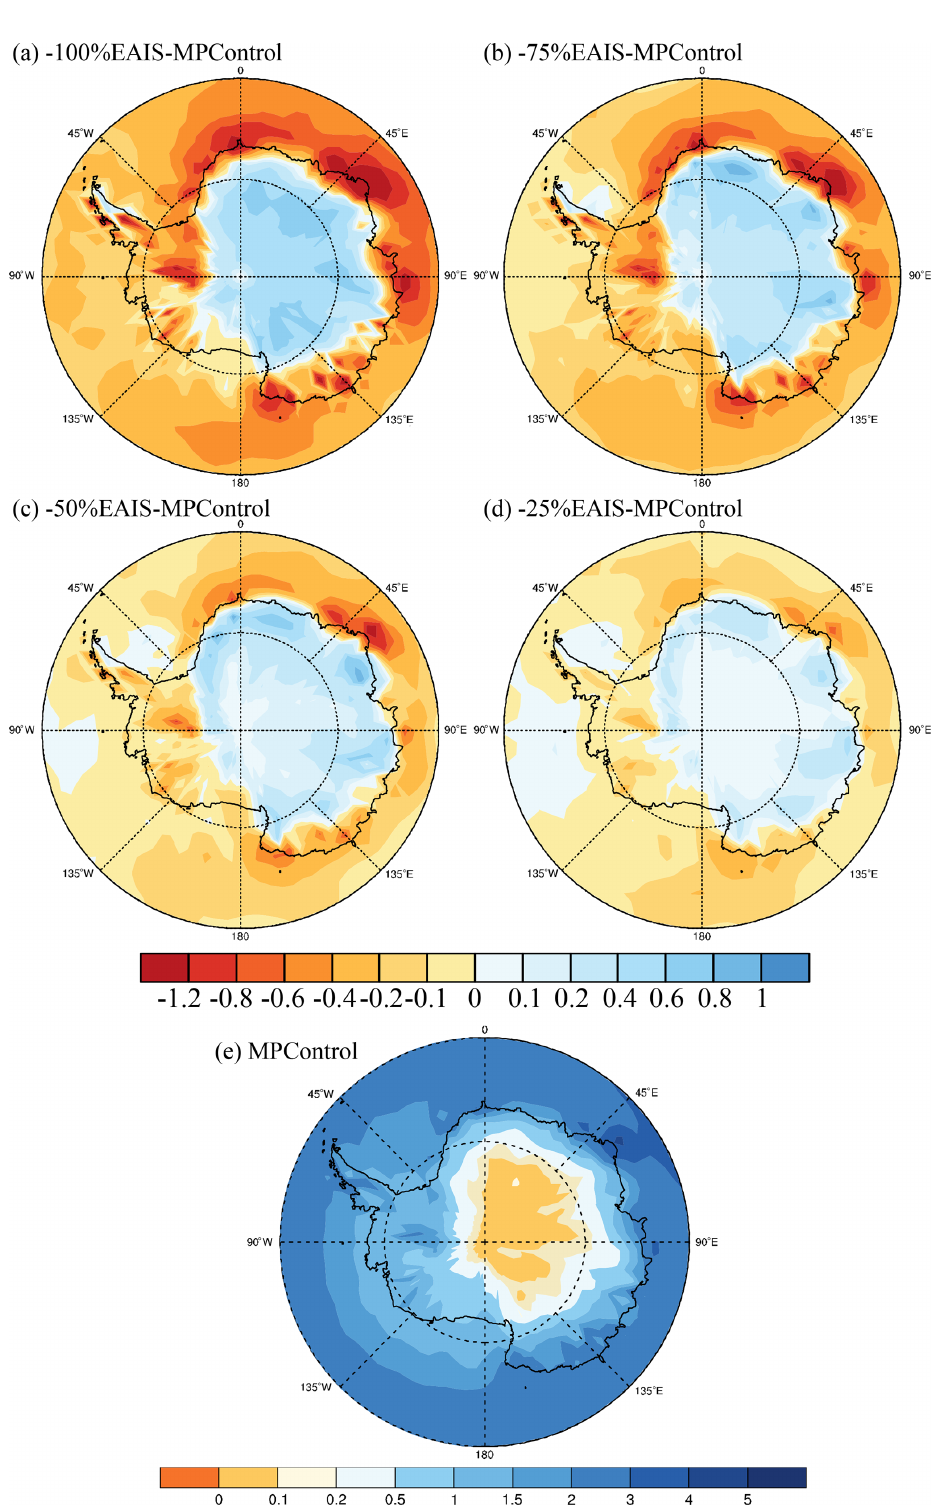
Figure 4. Spatial distribution of the annual mean precipitation anomalies (units: mmd − 1 ) over Antarctica between sensitivity experiments and MPControl experiments (a–d) , and spatial distribution of the annual mean precipitation over Antarctica for the MPControl experi- ments (e) .